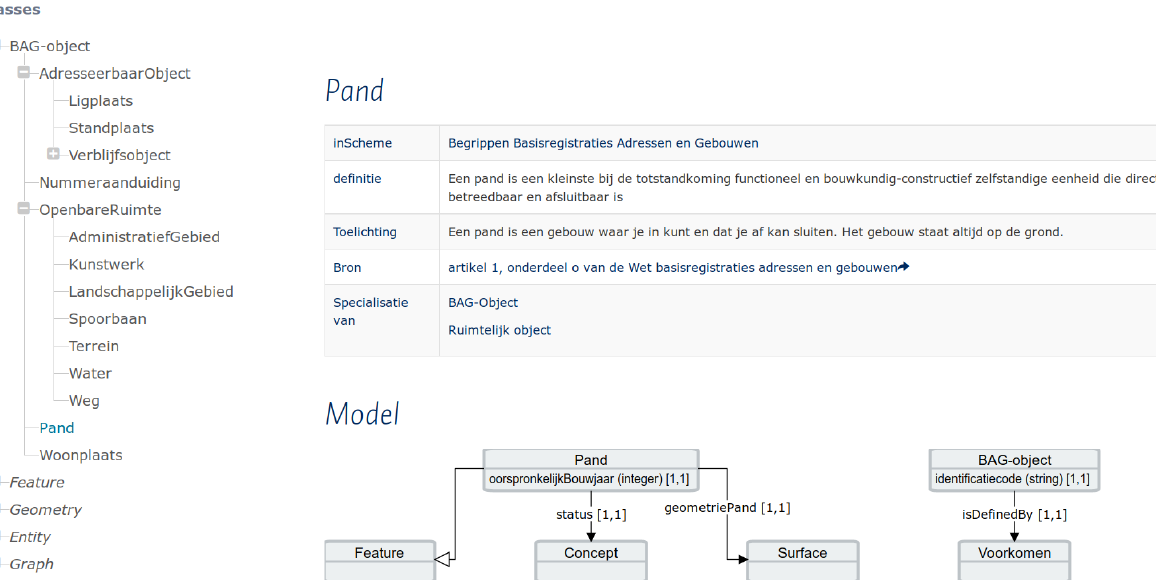
Figure 1. A view of the Linked Data Theater hierarchical browser. The left-hand side shows a tree widget that represents the subclass hierarchy of the Ditch Base Registry for Buildings (BAG), from which the user has selected the building class (Dutch: “Pand”). The right-hand side shows a tabular and a schematic description of that